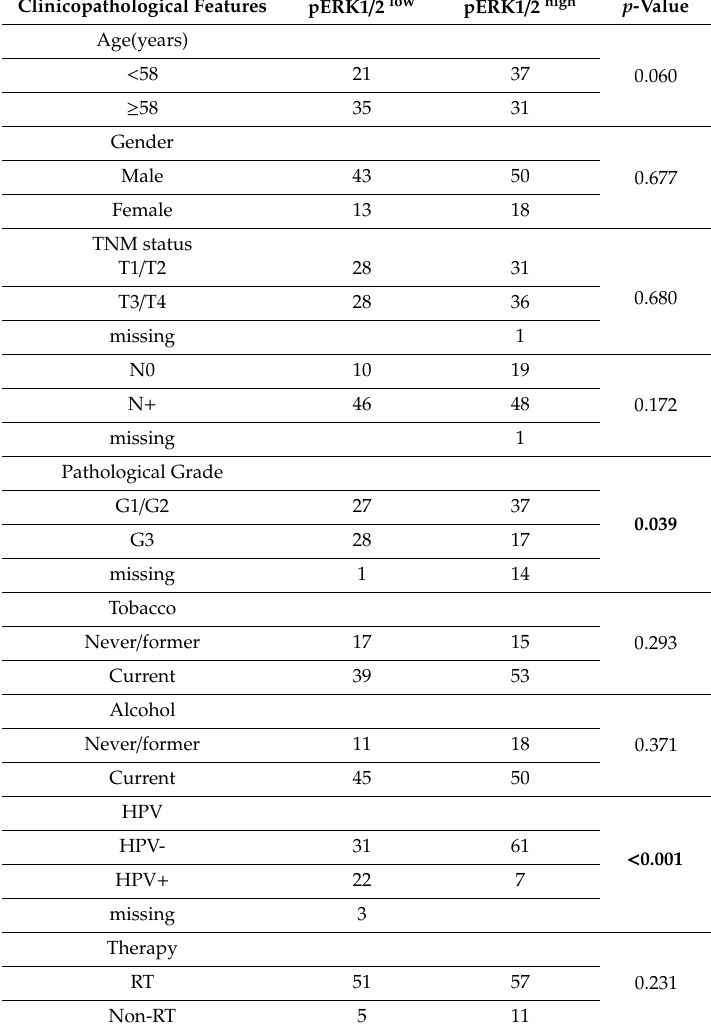
Figure 1. Immunohistochemical staining of pERK1 / 2 on tissue microarrays. Representative pictures of primary tumor sections with negative pERK1 / 2 immunostaining ( A ) and moderate pERK1 / 2 immunostaining ( B ); strong pERK1 / 2 immunostaining ( C ) (brown signal represents pERK1 / 2 protein expression; T: tumor; S: stroma; bars indicate 100 µ m). Table 1. Association between pERK1 / 2 expression and clinicopathological features in oropharyngeal squamous cell carcinoma (OPSCC) patients, treated between 1990 and 2008 in Heidelberg ( n = 124). Clinicopathological Features